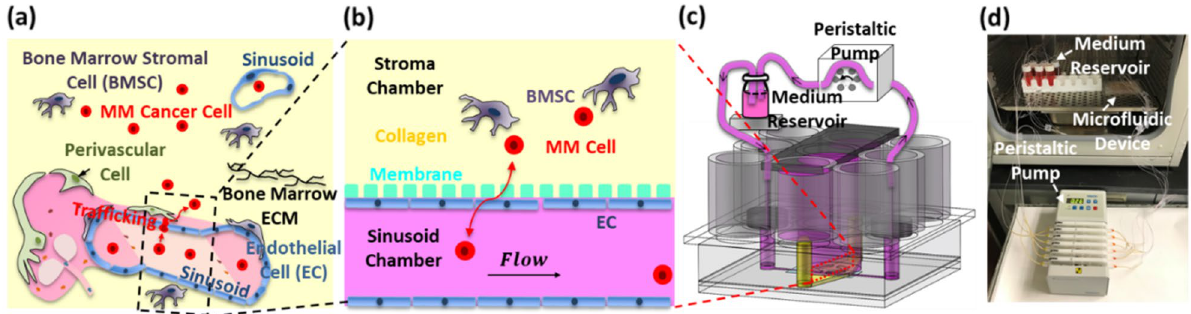
Figure 1. Microfluidic culture device designed to mimic the trafficking of cancer cells through the sinusoidal niche of bone marrow (BM). ( a ) Schematic illustration of major physiological features of the sinusoidal niche. ( b ) Schematic illustration of the recapitulated sinusoidal niche in the device. ( c ) Device design based on a 96-well plate configuration. ( d ) Actual device operated inside an incubator using an external peristaltic